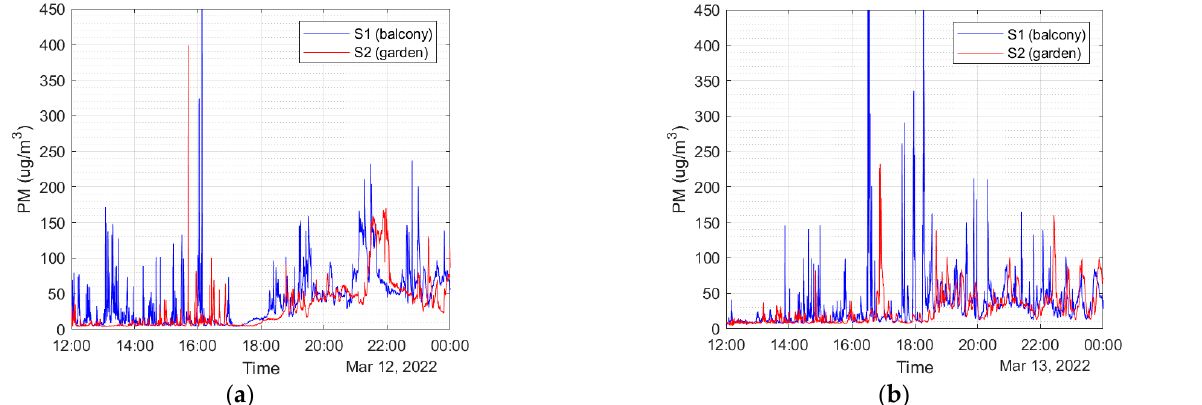
Figure 6. Measurement of PM10 on the balcony (blue line) and in the garden (red line) in